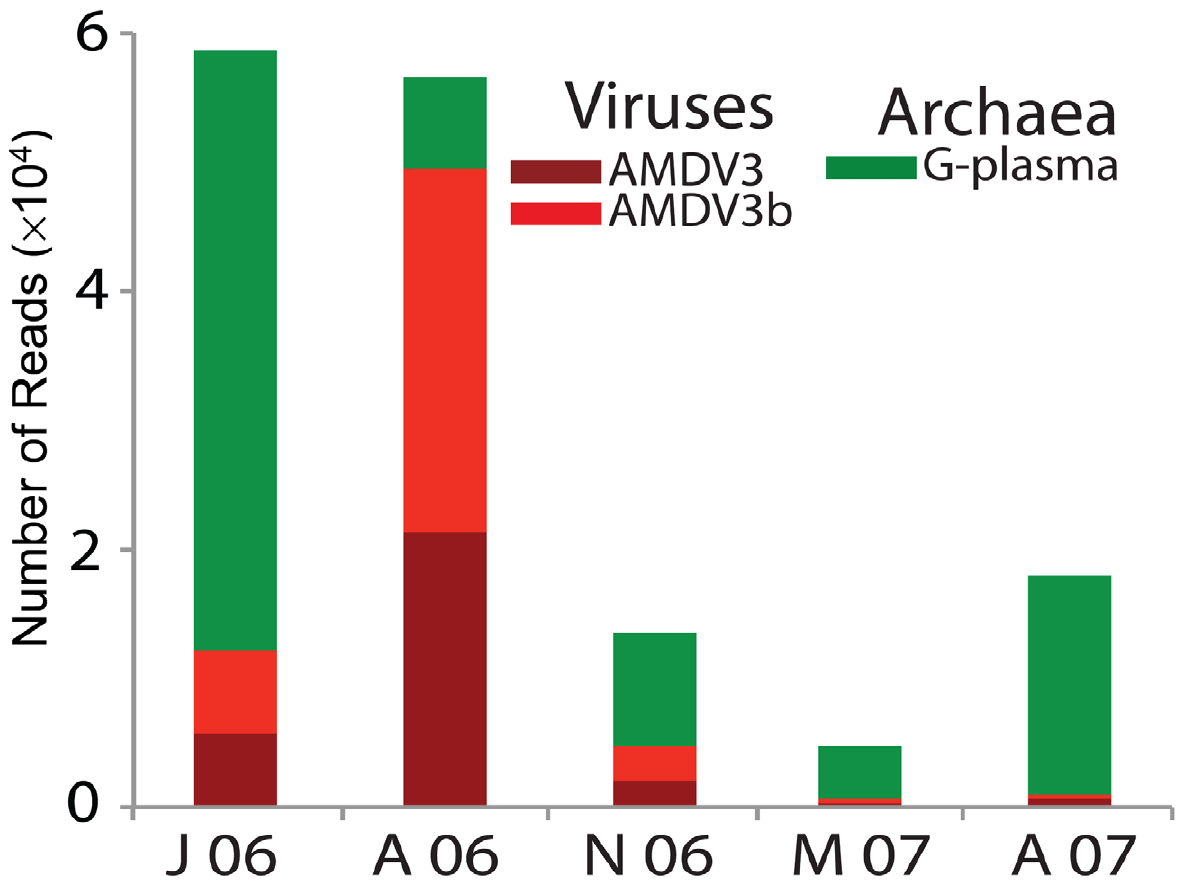
Figure 8. Metagenomic sampling across time captures a natural viral bloom. Number of sequencing reads of G-plasma and its viral populations, AMDV3 and AMDV3b, calculated from the community genomic data at a single location across five time points in 2006–2007. Relative abundances of all archaeal, bacterial, viral and plasmid genomes reconstructed from this community during 2006–2007 are shown in Figure S9. Both Figures 8 and S9, capture a bloom of AMDV3b virus (bright red) at the second time point, August 2006, coincident with the depletion of its archaeal G-plasma host (bright green). Notably, the G-plasma CRISPR loci from these time points were reconstructed in samplings (3)–(7) of Figures 1 and 2. G- plasma contained several spacers exactly matching the blooming AMDV3b sequences prior to the August 2006 bloom (black diamonds in Figure 2).